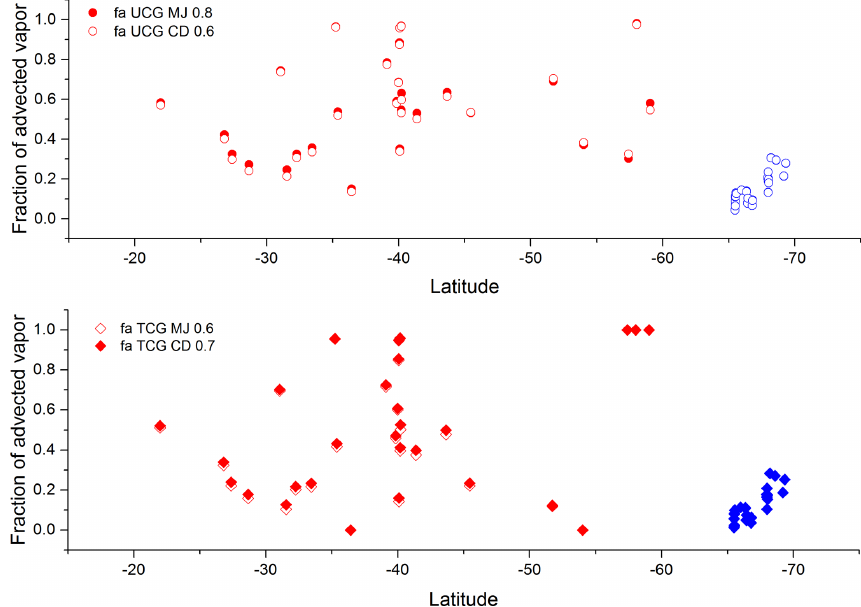
Figure 12. Fraction of advected vapor that explains the water vapor isotopic composition for the best-fit model runs. Red and blue colors depict the different end-member compositions used for